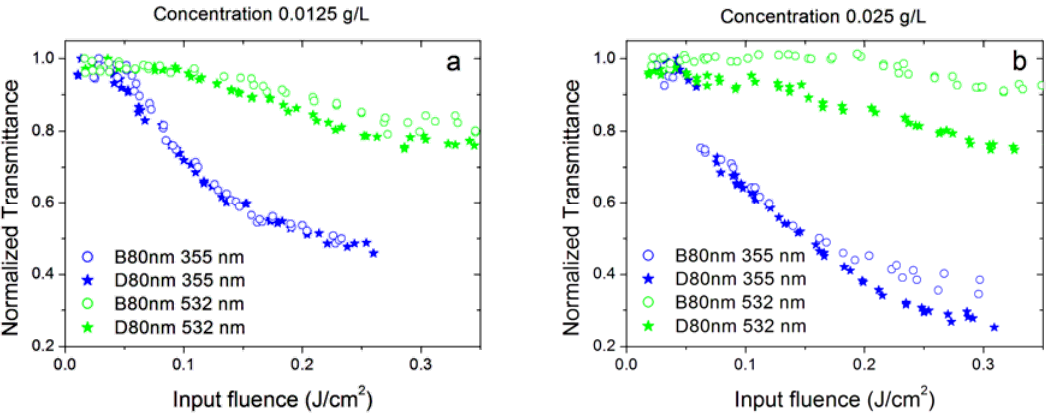
Figure 8. Optical limiting properties of the sample D80nm (dahlia—80 nm) and B80nm (bud—80nm) at 355 and 532 nm wavelengths, for nanoparticle concentration of 0.0125 ( a ) and 0.025 g/L ( b ).